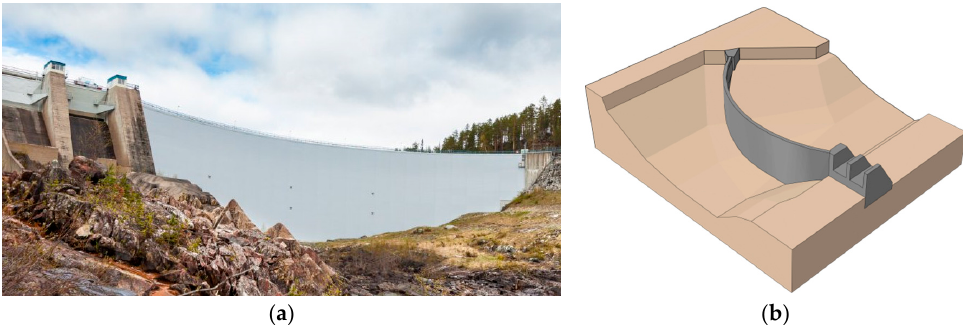
Figure 1. ( a ) Photo of the concrete arch dam used as the reference for the benchmark workshop, ( b ) illustration of the dam geometry. From [1].